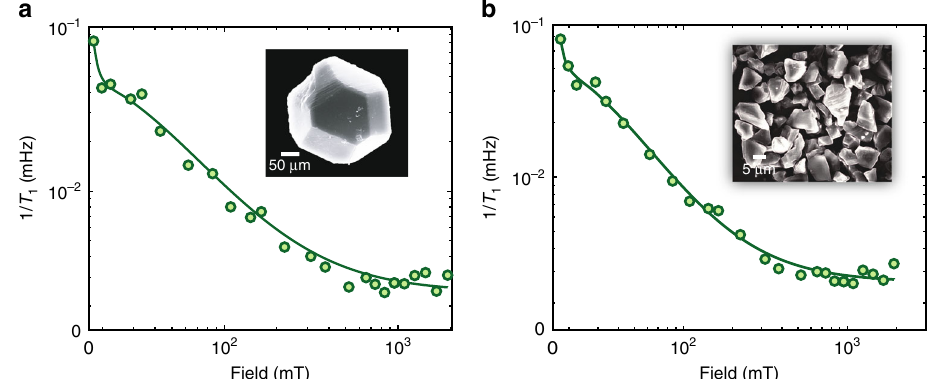
Fig. 4 13 C nuclear relaxation in microdiamond powder. Relaxation- fi eld maps for the randomly oriented natural abundance 13 C microdiamond powder Samples 3 and 4 of sizes ( a ) 200 µ m and ( b ) 5 µ m, respectively, with accompanying SEM images (insets). Data are obtained by measuring the full relaxation curve at every fi eld point, and is quantitatively similar to the single-crystal results in Fig.